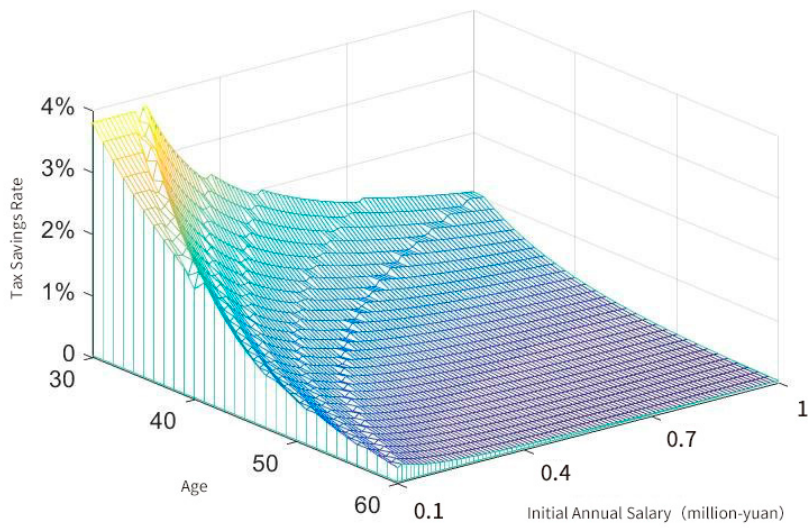
Figure 4. Changes in TSR for 30-year-old insured men under different initial insured annual salaries.